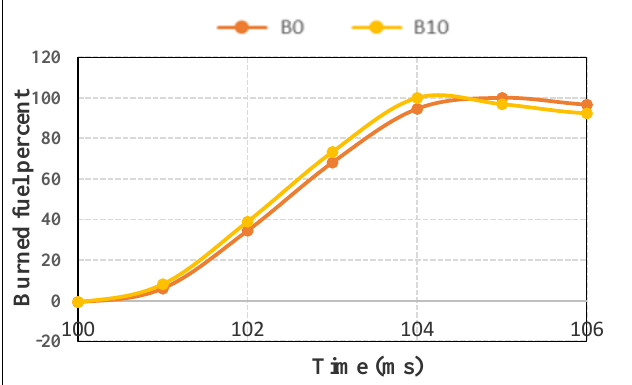
Figure 15. Evolution % of the fuel burn test.